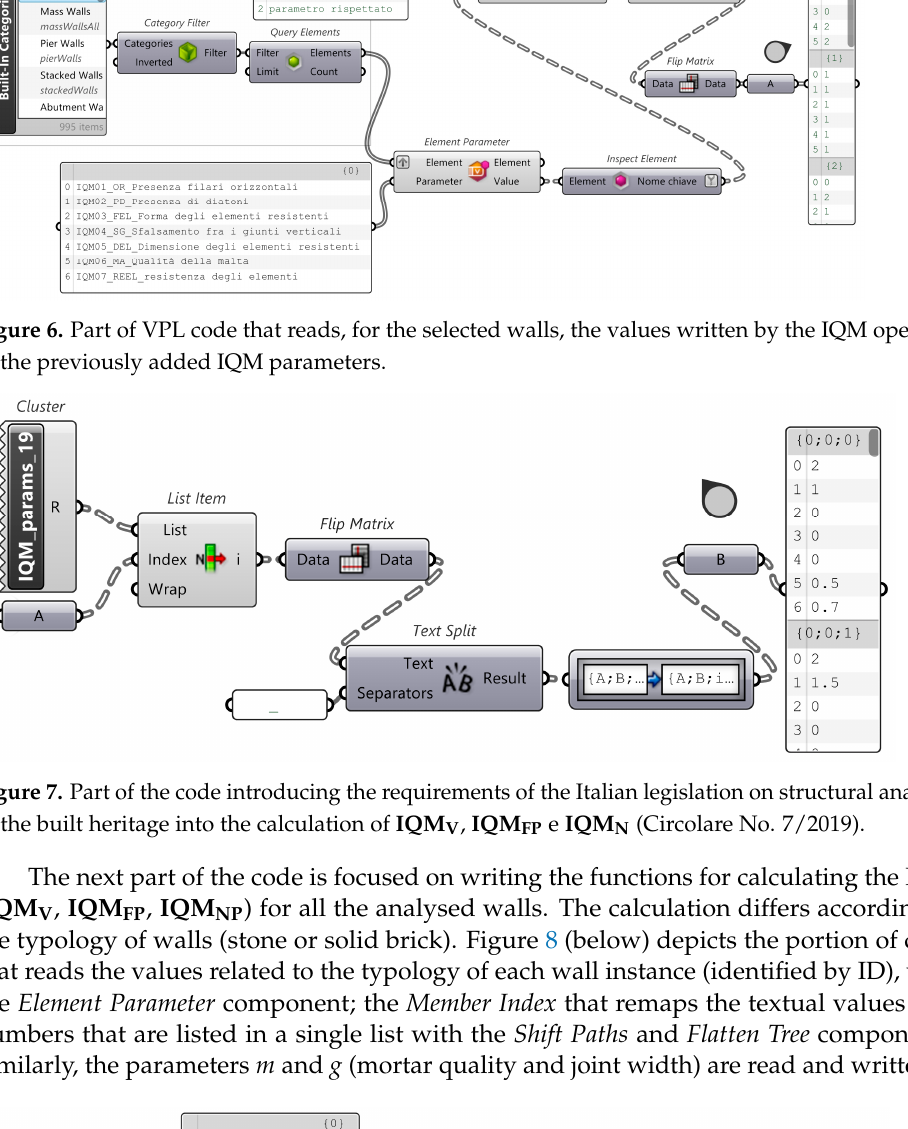
Figure 6. Part of VPL code that reads, for the selected walls, the values written by the IQM operator in the previously added IQM parameters.